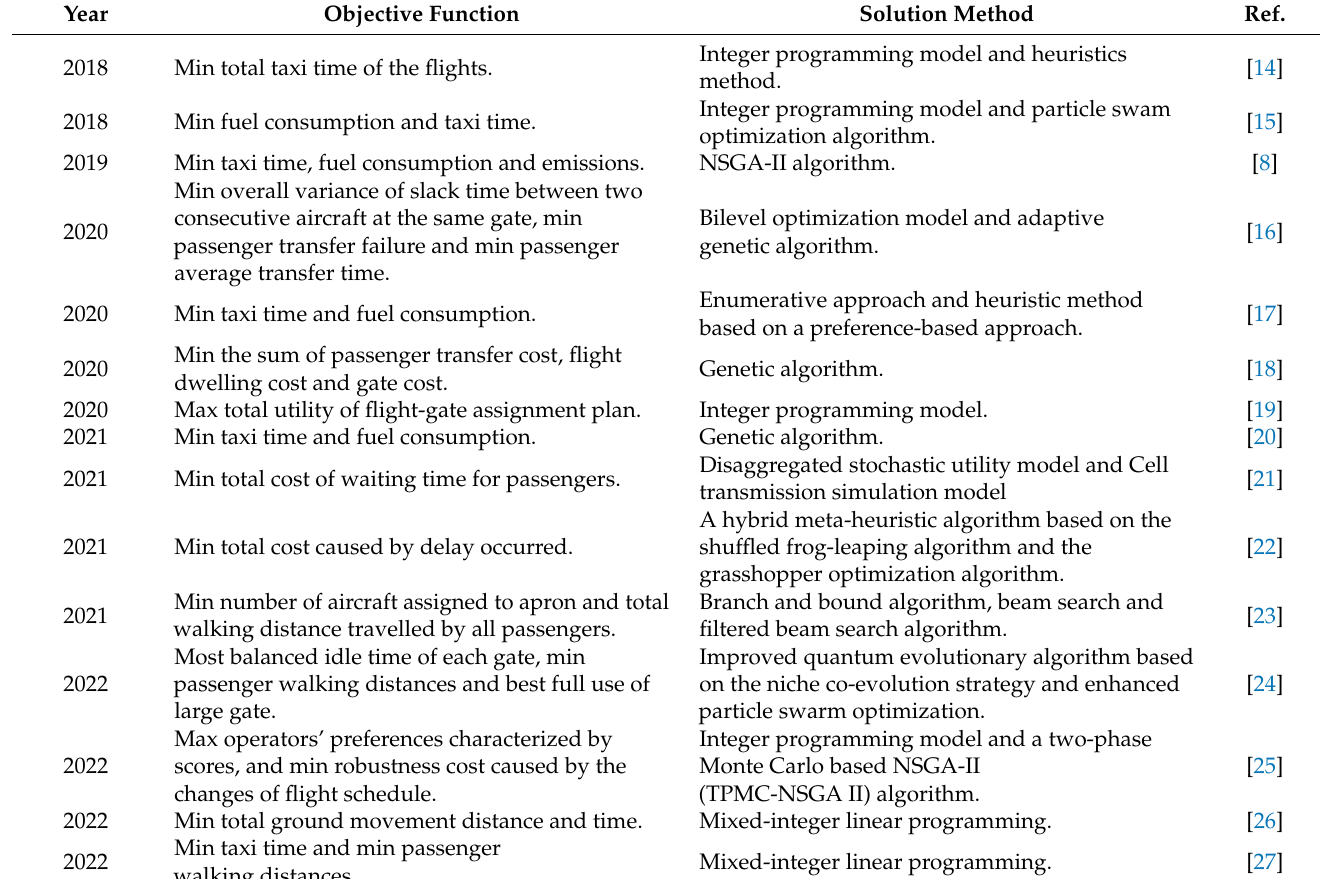
Mixed-integer linear programming.